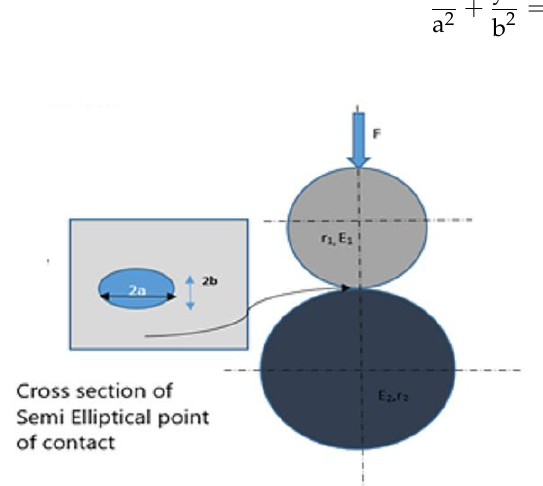
Figure 4. Cross-section to find contact radius.